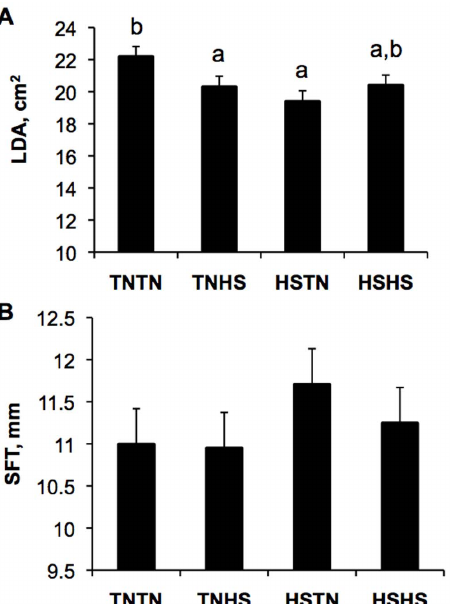
Figure 2. Effects of gestational thermal treatment on postnatal body composition indices at 12 weeks of age and prior to acute postnatal heat stress (HS). A) Longissimus dorsi cross- sectional area (LDA) is greater in pigs from TNTN dams compared to those from TNHS and HSTN dams, but not different than those from HSHS treated dams ( P= 0.03). B) No gestational effect is observed in subcutaneous fat thickness (SFT) at 12 weeks of age ( P= 0.58). Different letters indicate P ,